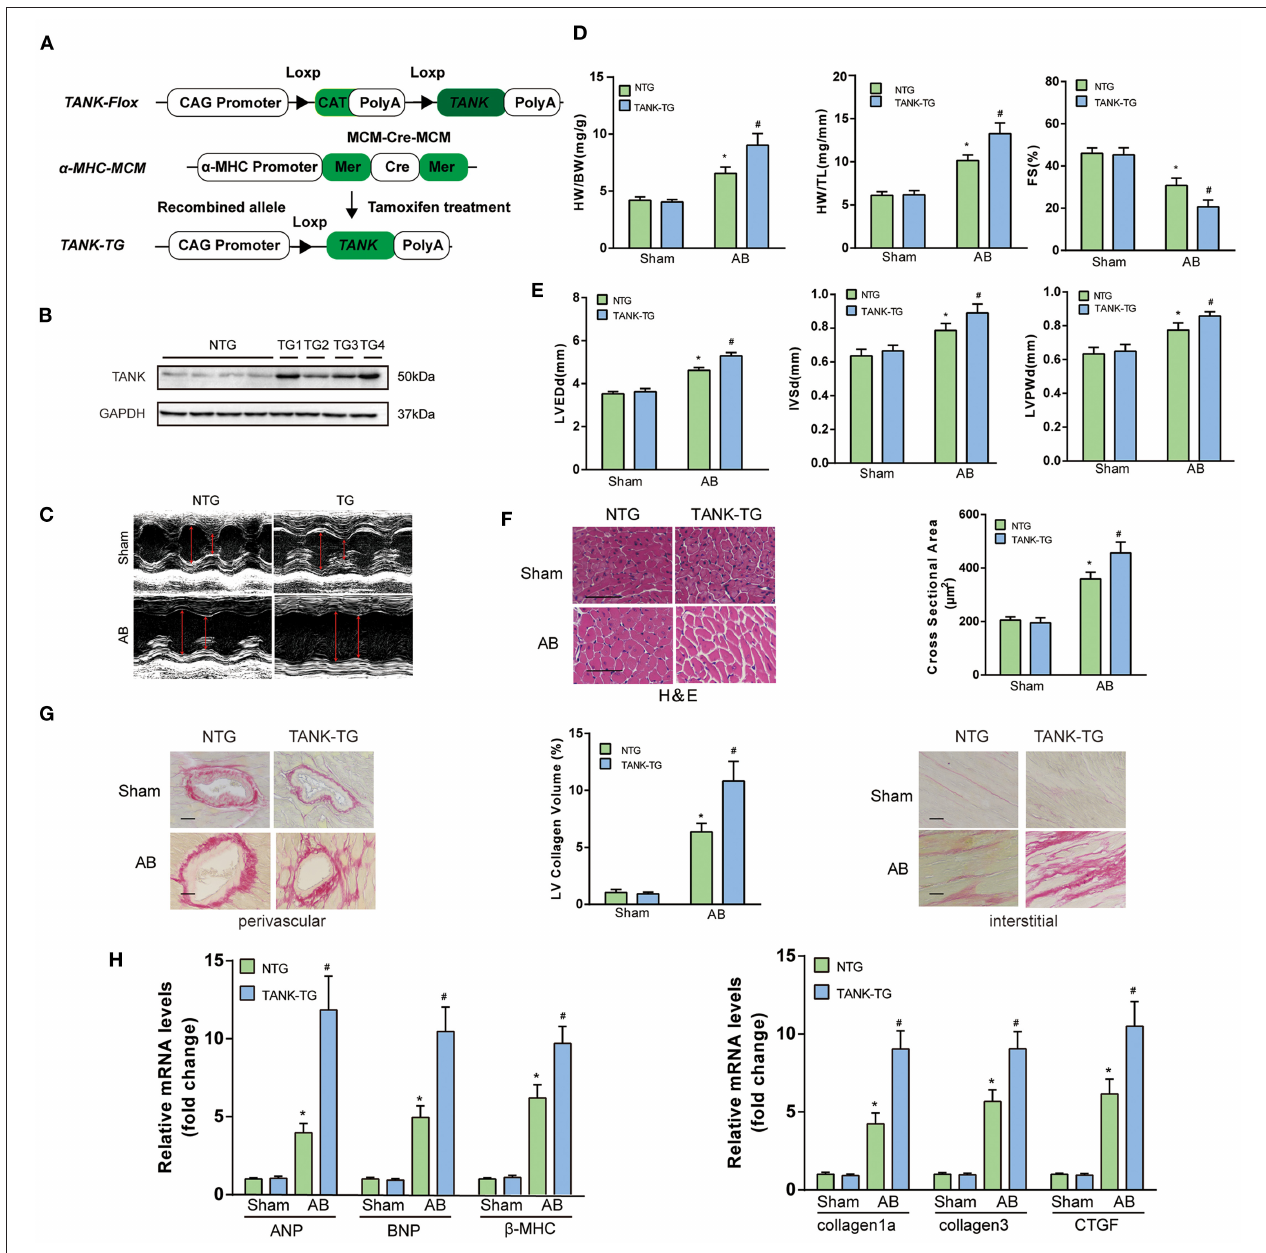
FIGURE 5 | TANK cardiac-specific overexpression results in the exacerbation of pressure overload-induced cardiac hypertrophy. (A) Schematic diagram of the construction of cardiac-specific TANK overexpression experimental mice. (B) Western blot showing TANK expression in mouse heart samples from nontransgenic (NTG) mouse hearts and cardiac-specific TANK transgenic (TANK-TG) hearts (TG1, TG2, TG3, and TG4; n = 4 mice per group). (C) M-mode echocardiograms from NTG group and TANK-TG mice after AB. (D) The HW/BW and HW/TL ratio determined in NTG and TANK-TG mice subjected to sham or AB treatment for four weeks ( n = 12-14 mice per group). (D,E) M-mode echocardiograms of NTG mice and TANK-TG mice after AB. Measurements of LVEDd, IVSd, LVPWd, and FS% using echocardiography of NTG and TANK-TG mice subjected to sham or AB treatment for four weeks ( n = 12–14 mice per group). (F) Representative histological cross-sections stained with H&E indicated concentric hypertrophy in NTG and TANK-TG mice subjected to four weeks of AB treatment ( n = 6 mice per group) (Left). Cross-sectional area of the indicated group was quantified ( n = 100 + cells per group) (Right). (G) Picrosirius red staining showing perivascular fibrosis (Left) and interstitial fibrosis (Right) in heart sections of NTG and TANK-TG mice ( n = 6 mice per group) , Scale bars, 50 µ m. Middle, Statistical results of LV collagen volume of the indicated group ( n ≥ 40 fields per group). (H) The relative mRNA levels of the hypertrophic markers ANP, BNP, and β - MHC (Left), or fibrotic markers collagen I α , collagen III, and CTGF (Right) in NTG and TANK-TG mice ( n = 4 mice per group) subjected to sham or AB treatment for four weeks. All the data are presented as the mean ± SD. * P < 0.05 vs. NTG/Sham or TANK-TG/Sham; # P < 0.05 vs. NTG/AB.